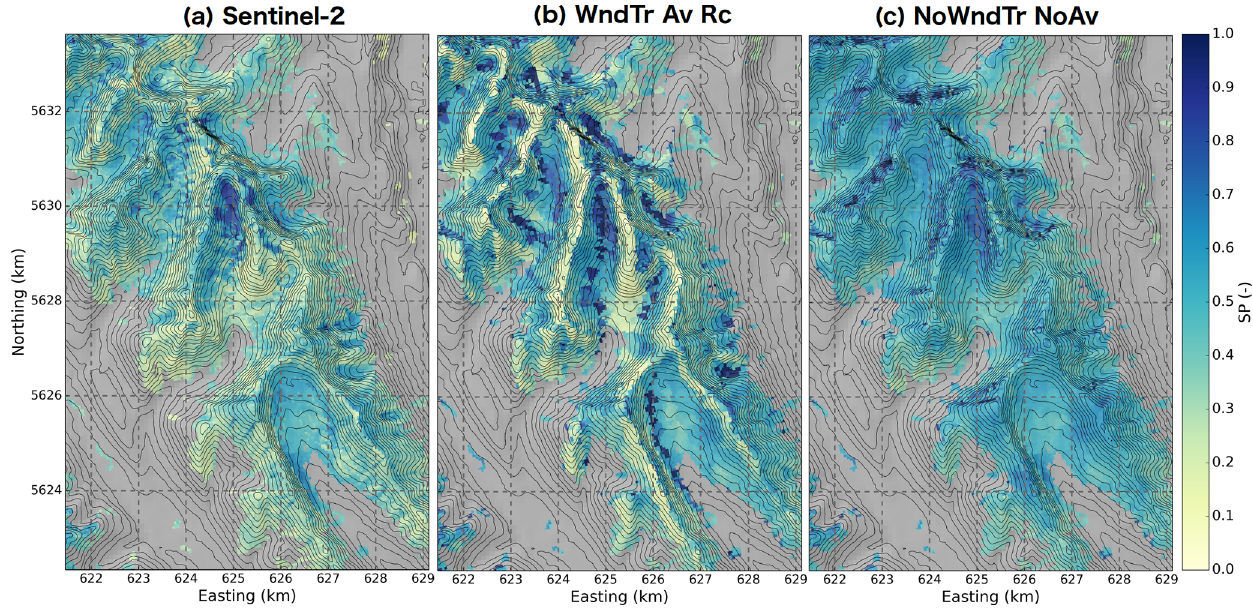
Figure 10. Maps of snow persistence index (SP) (a) derived from Sentinel-2 and simulated by two CHM configurations: (b) WndTr Av Rc, and (c) NoWndTr NoAv (Table 3). Pixels covered by tall vegetation in the observations and in the simulations are excluded from the comparison and appear in grey. Black isolines correspond to (cid:49) z = 50m, and the location of this region is shown in Fig.